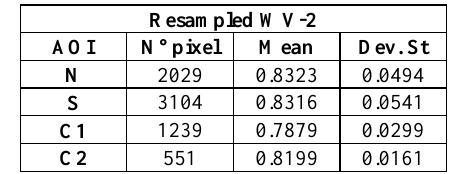
Table 7.Basic statistics of NDVI values for the resampled WV-2